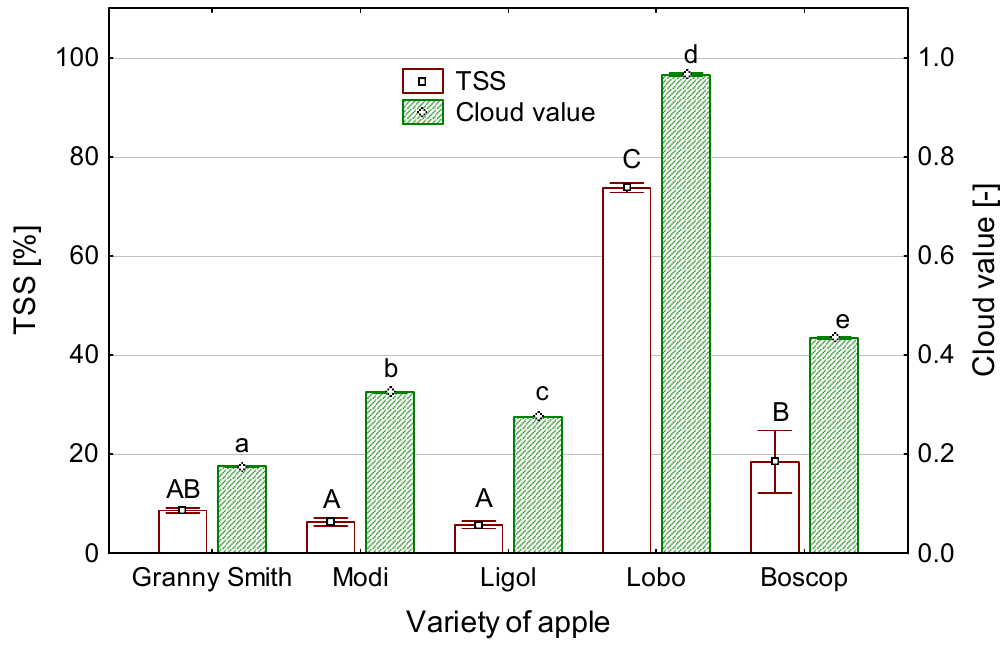
Figure 3. The influence of apple variety on cloud value and total suspended solids in apple juice. Different capital letters indicate values significantly different at p < 0.05 in the case of total suspended solids. Different lowercase letters indicate values significantly different at p < 0.05 for cloud value.